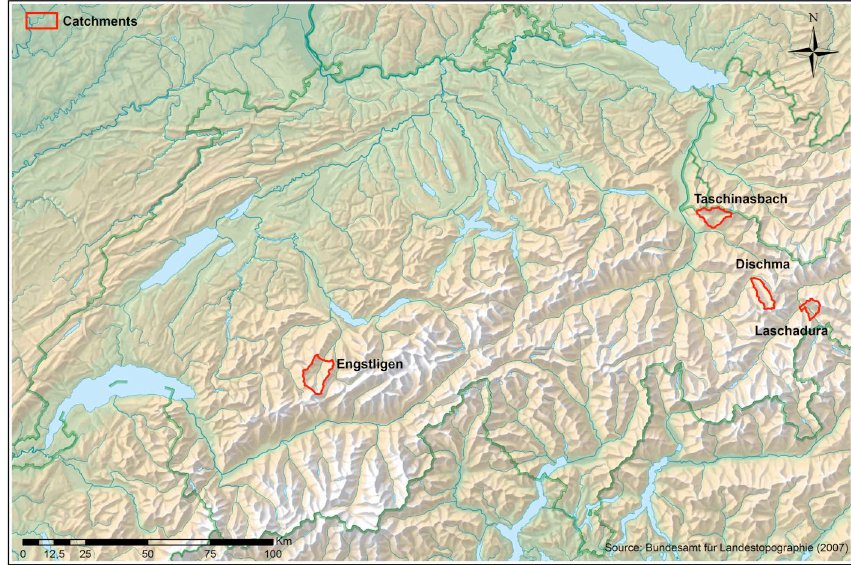
Fig. 1. Location of the four catchments in the Swiss Alps.